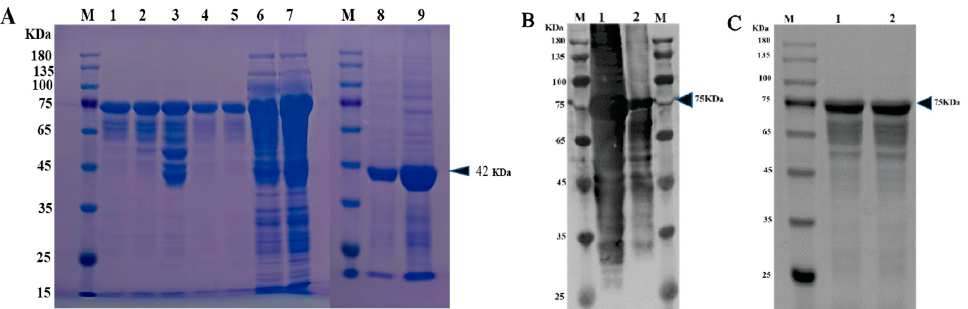
Figure 3. Expression and purification of PSV-VP1 protein in E. coli . ( A ) SDS-PAGE analysis of the MBP-tagged recombinant VP1-protein expression (~75 KDa). Lane M, protein marker; Lanes 1–5, purified bacterial cell lysates of MBP-tagged VP1 at different concentrations; Lines 6 and 7, unpurified bacterial cell lysate of MBP-tagged VP1; Line 8, sediment of bacterial cell lysate of empty vector, Line 9, supernatant of bacterial cell lysate of =empty vector (~42 KDa). ( B ) Western blot analysis of unpurified recombinant VP1-protein using anti-MBP tag antibody. Lane 1, 0.2 mg/mL of unpurified VP1 protein; Lane 2, 0.1 mg/mL of unpurified VP1 protein. ( C ) Western blot analysis of purified VP1-recombinant protein using anti-MBP tag antibody. Lane 1, 0.1 mg/mL of purified VP1 protein; Lane 2, 0.2 mg/mL of purified VP1